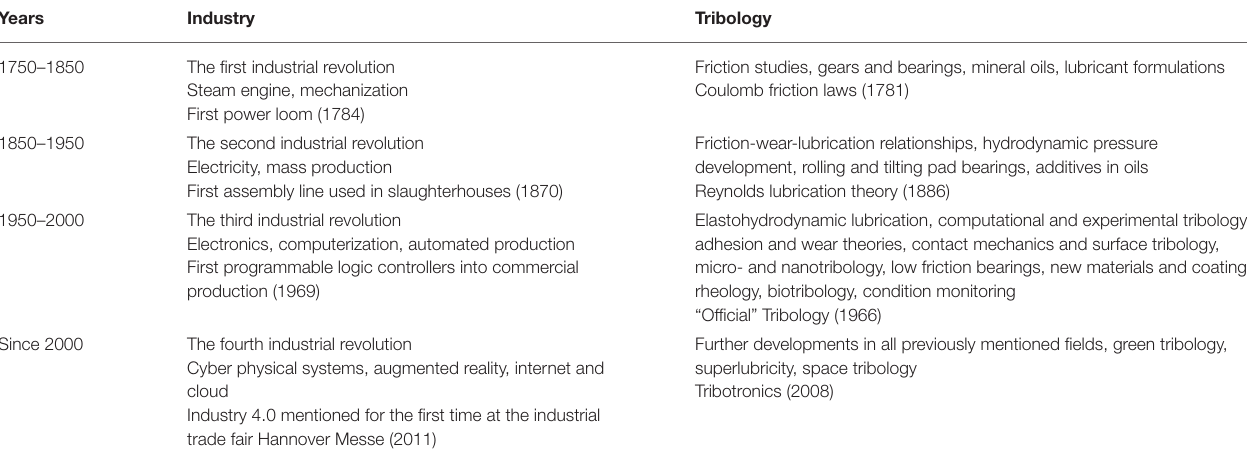
TABLE 1 | The fundamental aspects of industry and tribology during the four industrial and tribological evolutions time